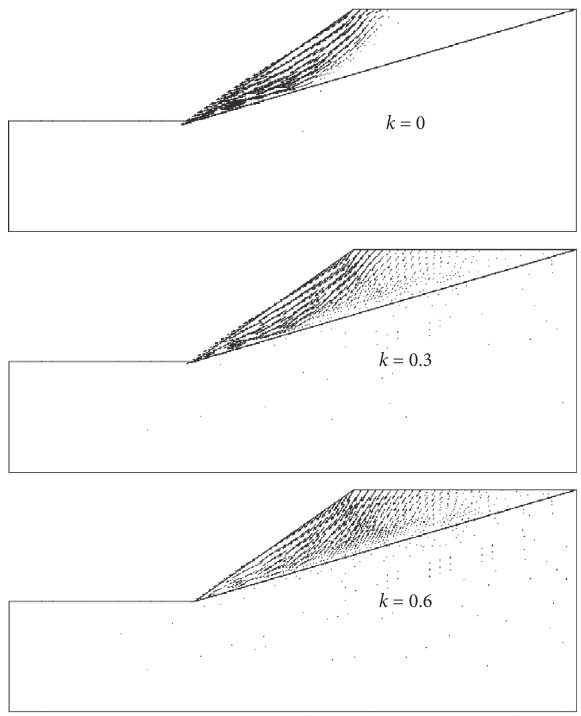
Figure 16: Displacement